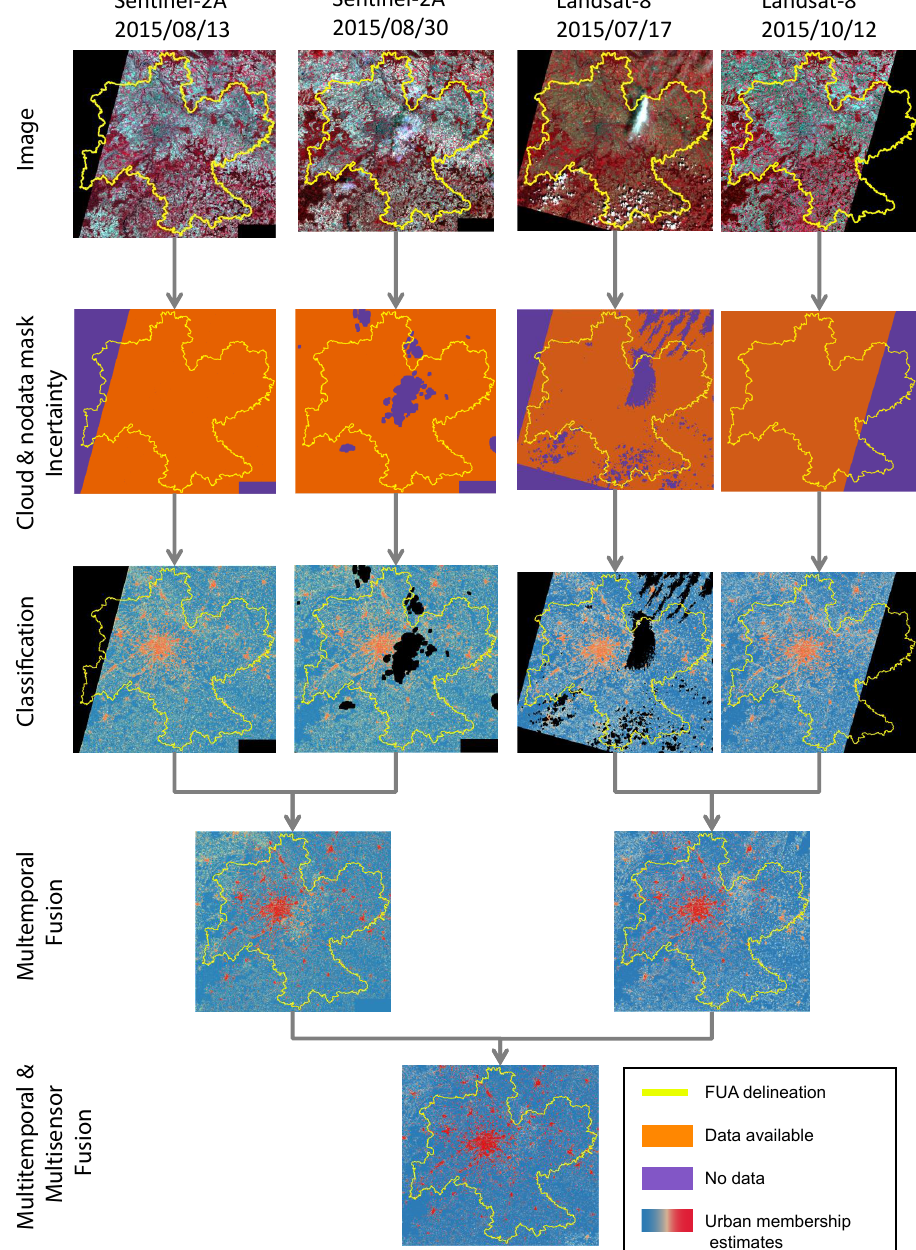
Figure 5. Results at various steps of the approach for Prague